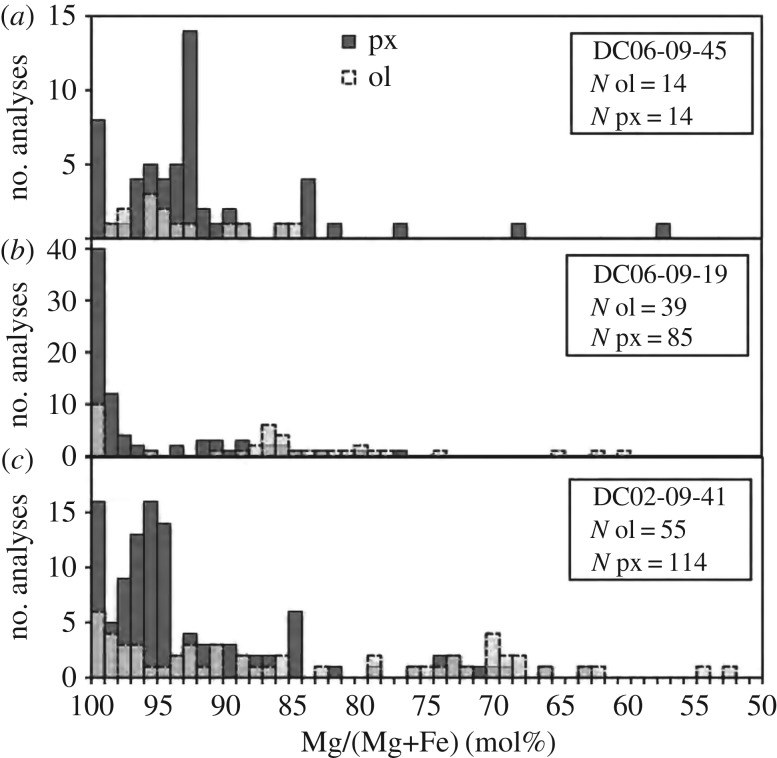
Frequency histograms showing the compositions Mg/(Fe + Mg) (mol%) of olivines (dashed line, light grey) and pyroxenes (filled line, dark grey) in crystalline assemblages of ultracarbonaceous micrometeorites (UCAMMs)(a, DC06-09-45; b–DC06-09-19 and c—DC02-09-41) with the number (N) of measurements made in each sample (reproduced with permission from [272], fig. 5. Copyright © 2012 Elsevier). For comparison to figure 14, Fe/(Fe+Mg) (mol%) = 100 – (Mg/(Fe+Mg)) (mol%), i.e. 100 (mol%) on scale Mg/(Mg+Fe) equals 0 (mol%) on scale Fe/(Mg+Fe).